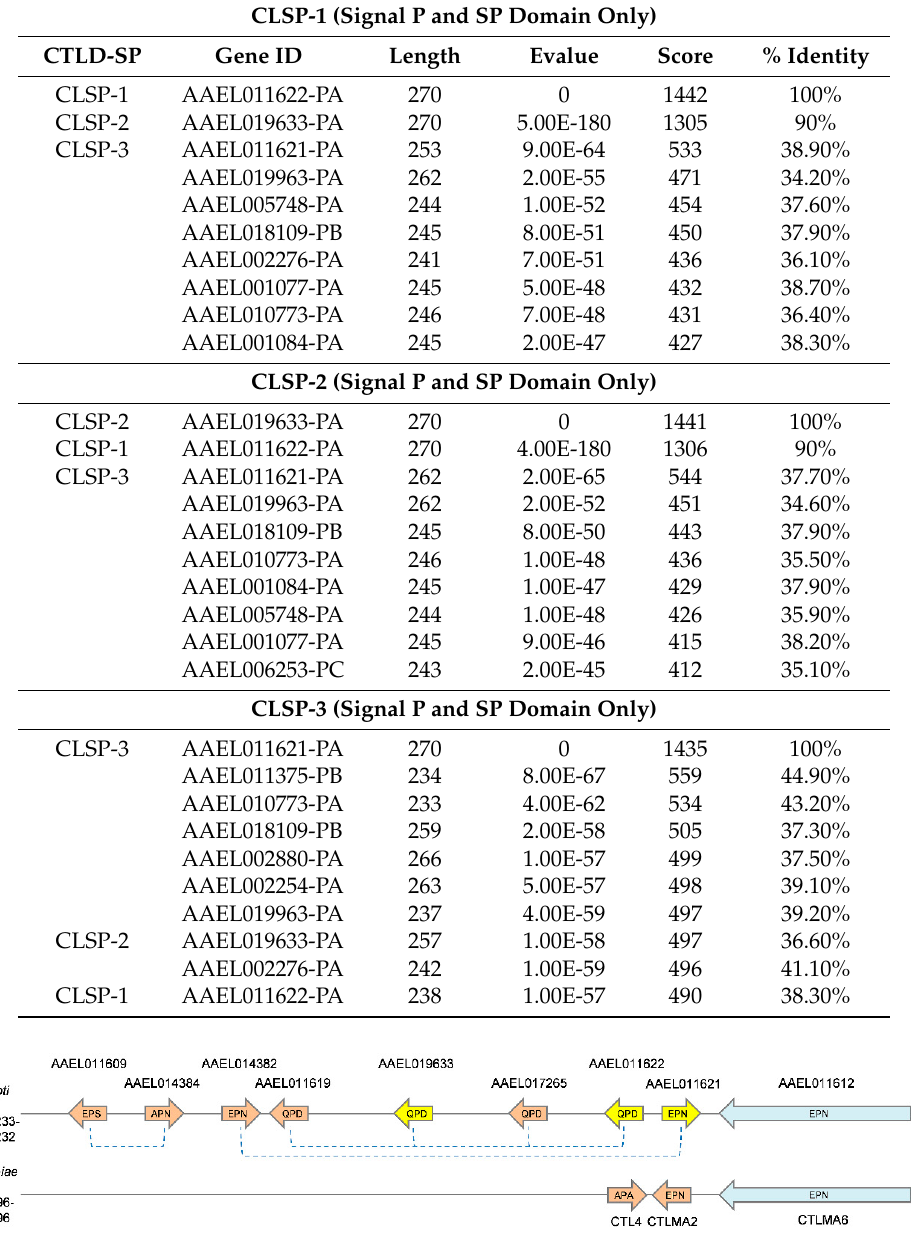
Table 1. Relationship between serine protease domains of CTLD-SP genes and potential ancestral serine proteases in the A. aegypti genome.